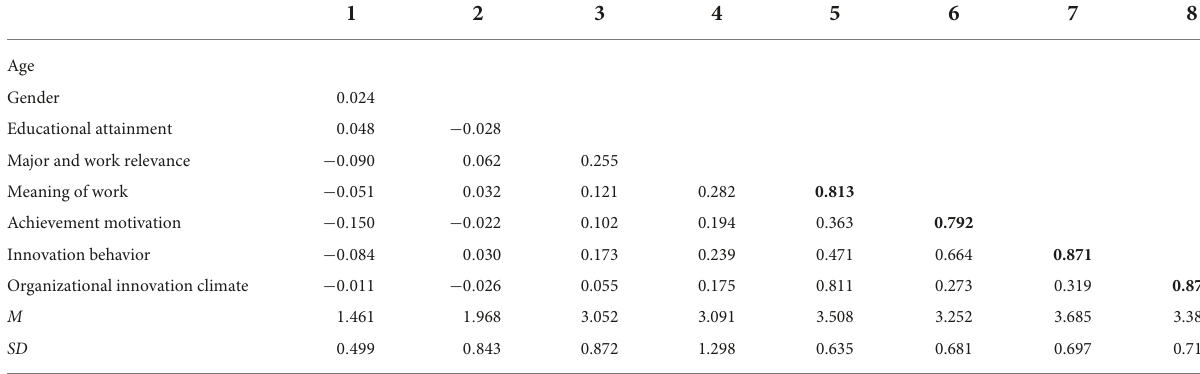
TABLE 3 Mean, standard deviation, and correlation values of study variables.